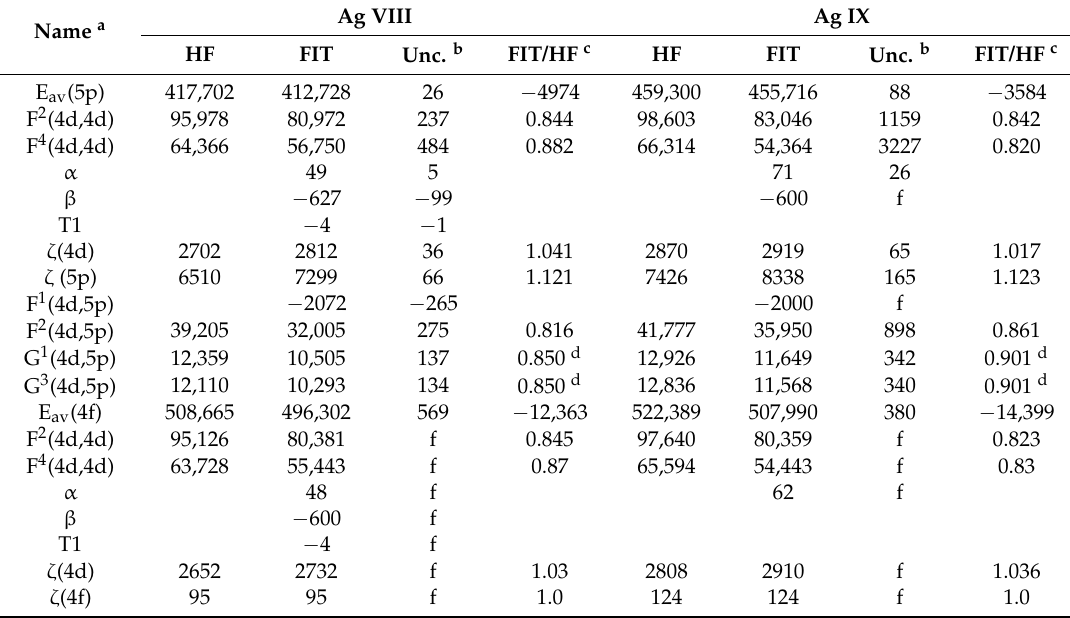
Table A14. Fitted (FIT) with their uncertainties (Unc.) and Hartree - Fock (HF) energy parameters in cm − 1 of the odd 4d 3 5p, 4d 3 4f, and 4p 5 4d 4 configurations in Ag VIII and 4d 2 5p, 4d 2 4f and 4p 5 4d 3 configurations in Ag IX calculated with the Cowan